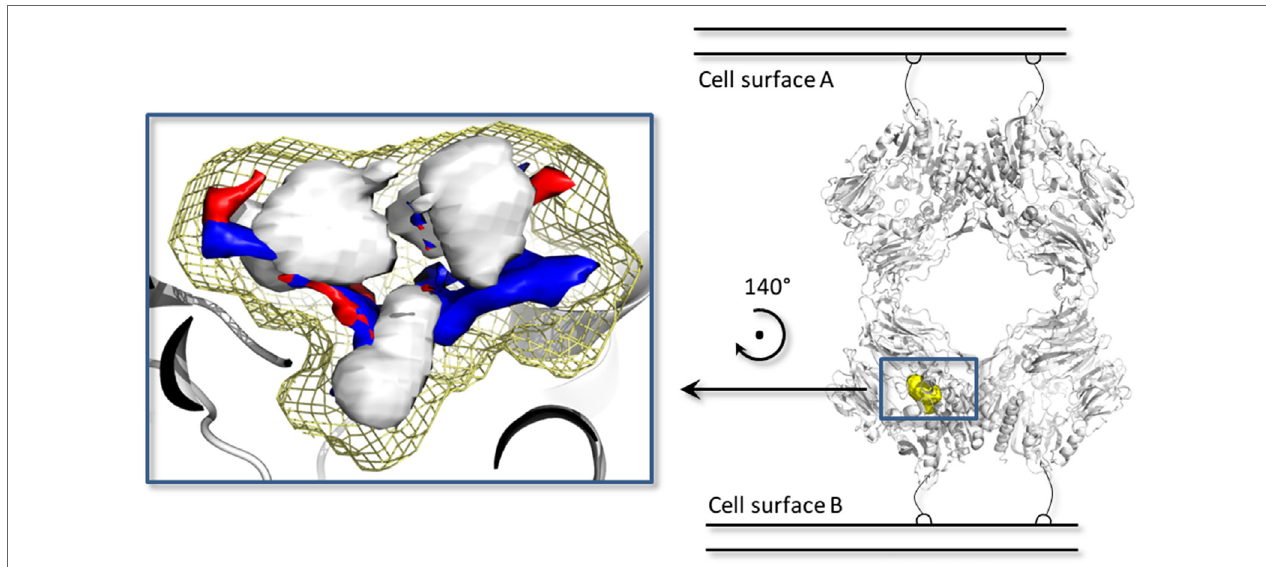
FigUre 5 | The biological assembly of the porcine dipeptidyl peptidase IV (DPP-IV) (PDB ID 1ORW) (26) is represented in cartoon on the right side, while a close up of pharmacophoric environment of the binding site is represented on the left. The yellow mesh retraces the shape of the binding site, while the white, blue, and red contours identify regions sterically and energetically favorable for hydrophobic, hydrogen bond donor and hydrogen bond acceptor groups,